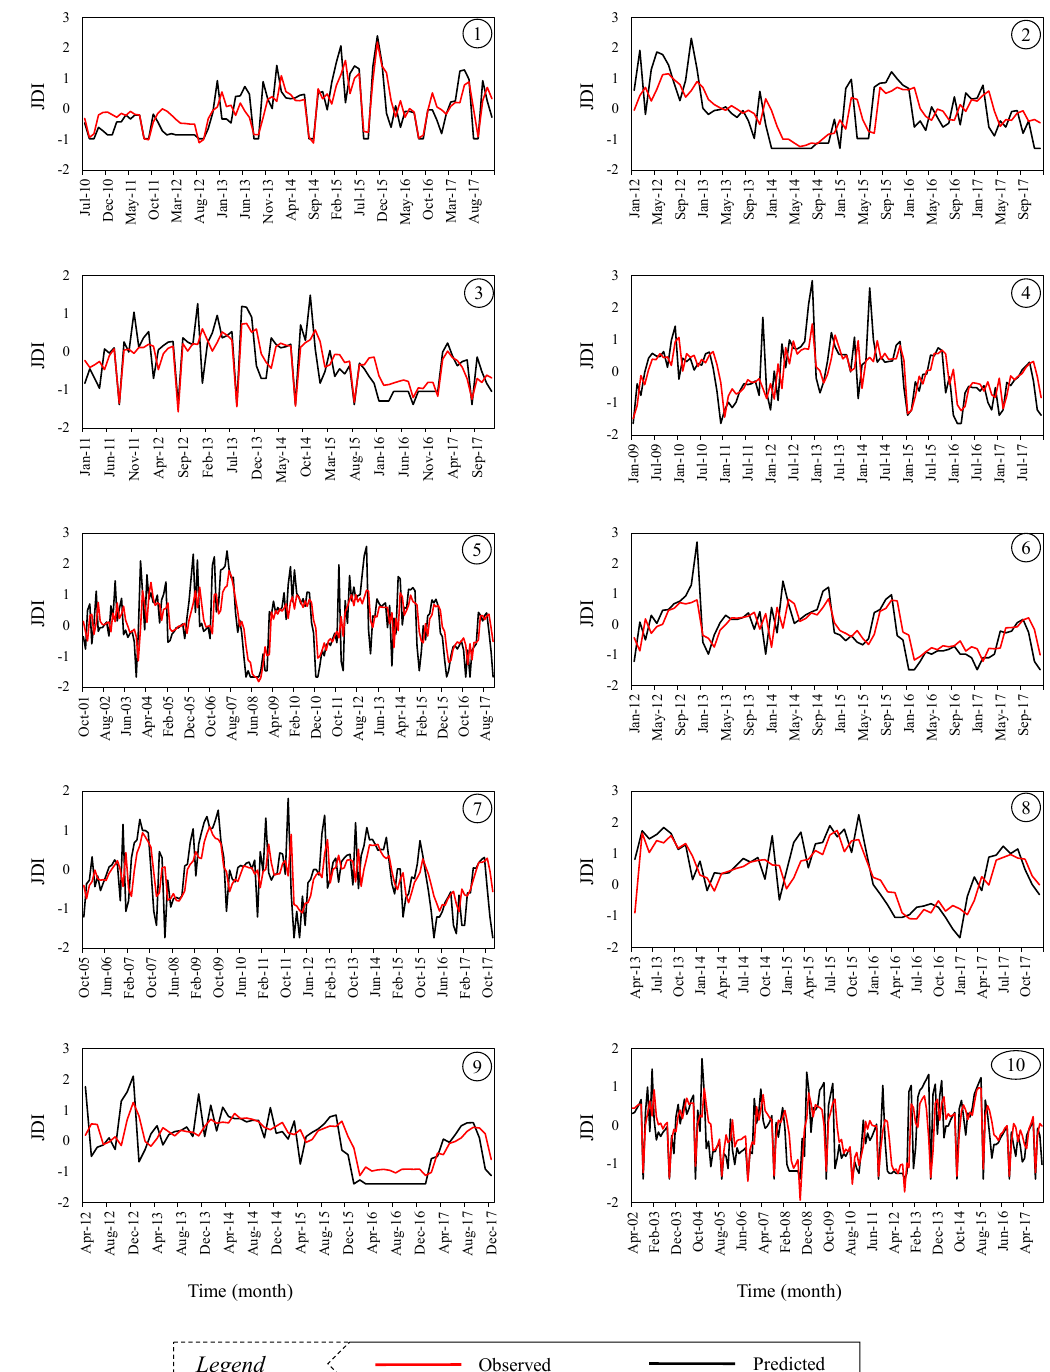
Figure 3. The variation of forecasts and observations for the JDI prediction in all of the stations; The numbers of the subplots refer to the stations including Anar (1), Biarjmand (2), Boshrouyeh (3), East Isfahan (4), Isfahan (5), Kabootarabad (6), Kashan (7), Marvast (8), Naein (9) and Yazd (10).